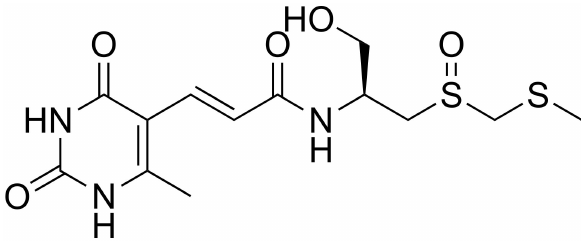
Figure 1. The structure of